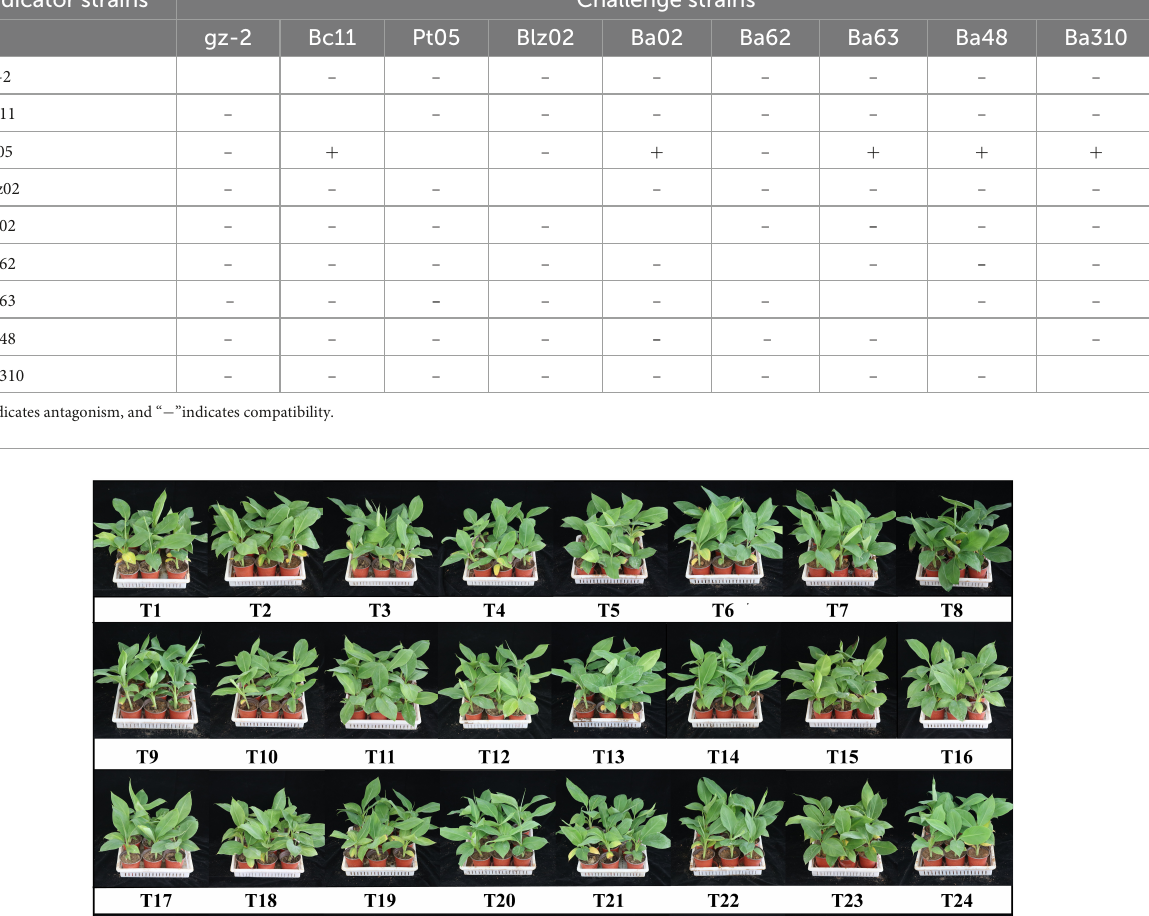
ranging between 63.13 and 65.46%. Overall, T28 of the four- strain combination (Pt05 + Bc11 + Ba62 + gz-2) showed the best stability and control against FWB compared to the other 7 combinations in different types of